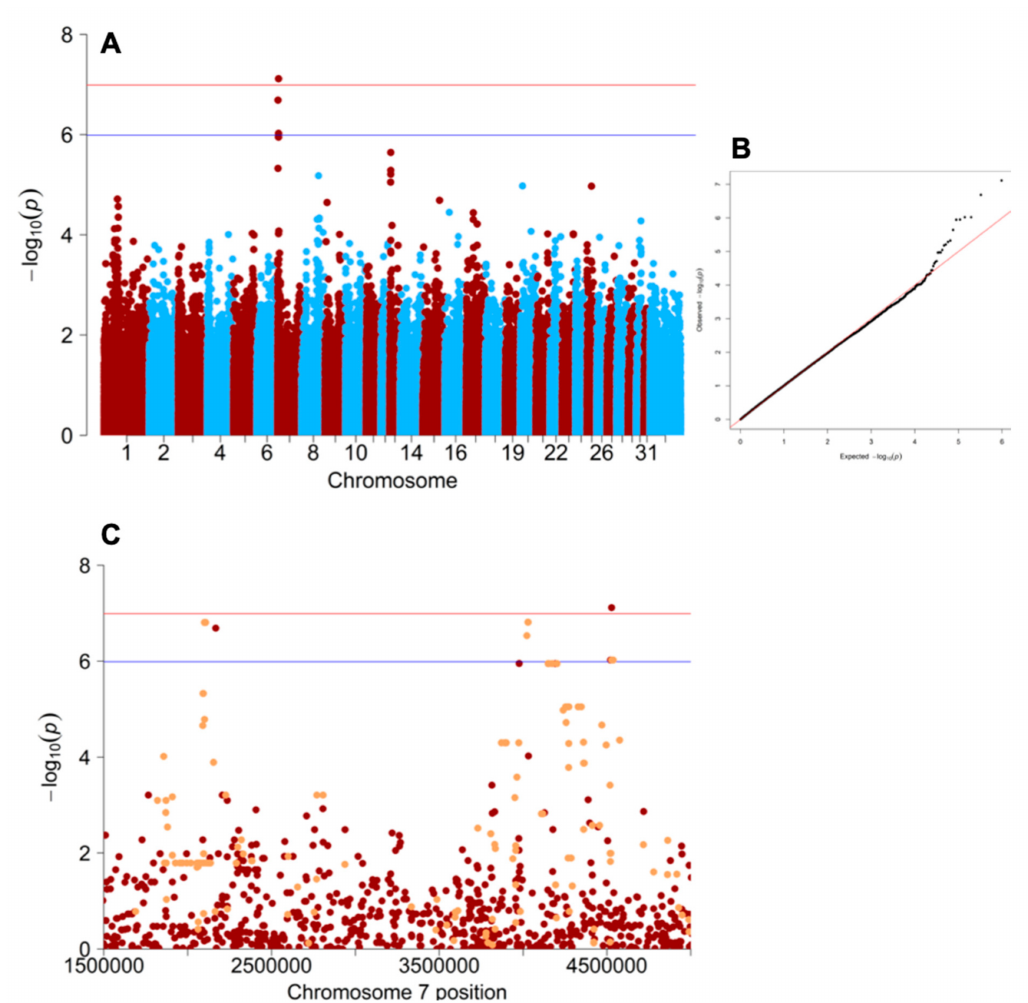
Figure 1. A 2.5 Mb region on ECA7 is associated with the equine neuroaxonal dystrophy / equine degenerative myeloencephalopathy (eNAD / EDM) phenotype. ( A ) Manhattan plot of the original genome-wide association study (GWAS) results showing the associated region on ECA7. The red line indicates Bonferroni corrected significance ( p = 1.024 × 10 -7 and -log( p ) = 6.99), and the blue line represents and 10% False Discovery Rate (FDR) correction ( p = 1.024 × 10 -6 and -log( p ) = 5.99). ( B ) Q-Q plot showing a low likelihood of false positives or negatives. ( C ) Manhattan plot of ECA7 with GWAS data in red and variants from the MassARRAY ® data highlighted orange. Red and blue lines have same values as in (A). All data are listed by their EquCab3.0